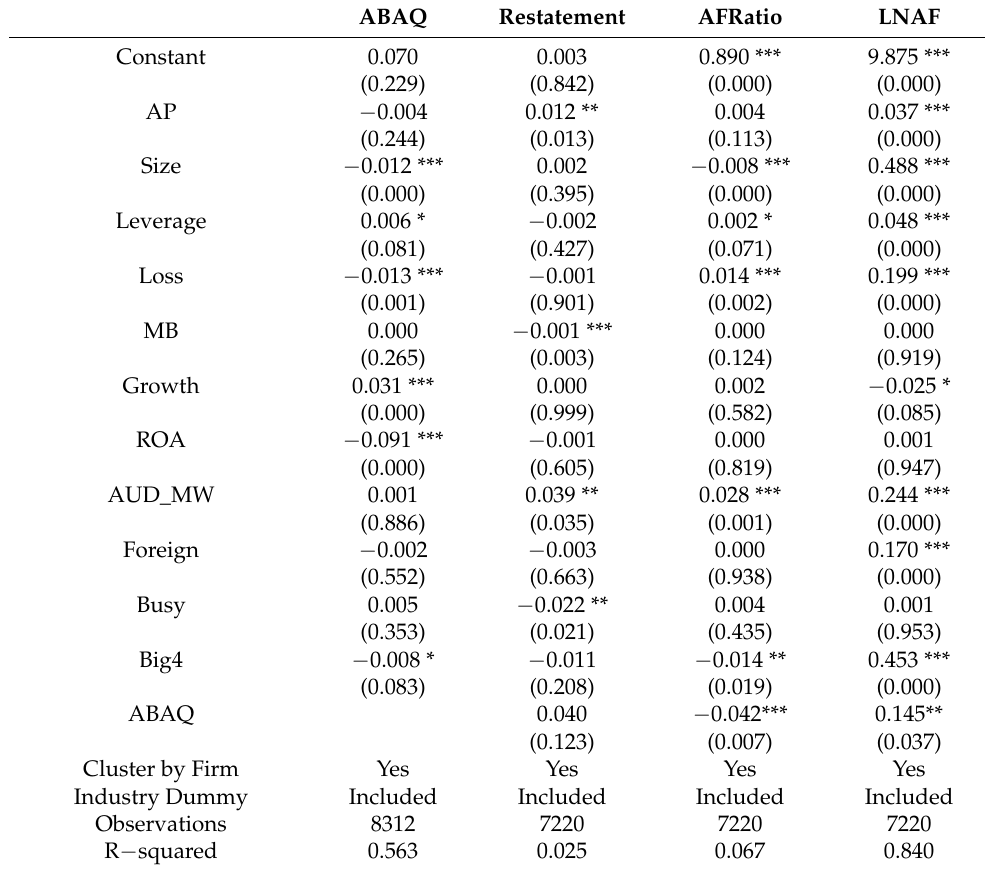
Table 4. Regression results of the association between PCAOB Rule 3211 and audit quality and audit fee for the US